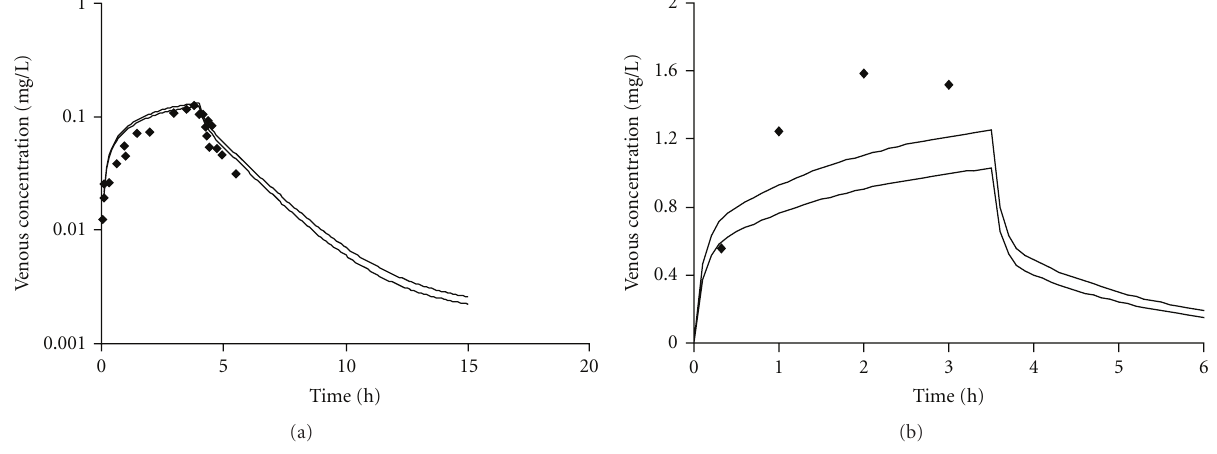
Figure 7: Comparison of PBPK model simulations (bold lines: predicted LMCI and UMCI for CL int ) with experimental data of venous blood concentration following inhalation exposure to (a) 8 ppm, 4h 1,2,4-trimethylbenzene [59] and (b) 175 ppm, 3.5h 1,1,1-trichloro ethane